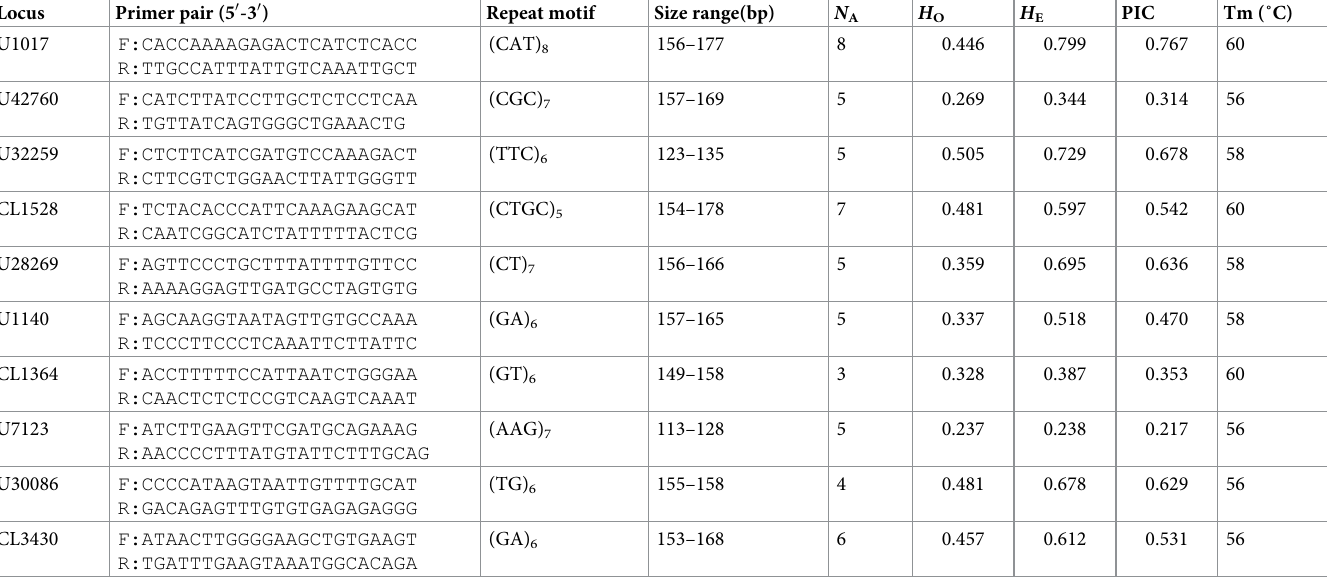
Table 2. Ten EST-SSR markers developed in A . emeiensis and characteristics of each primer pairs. Locus Primer pair (5 0 -3 0